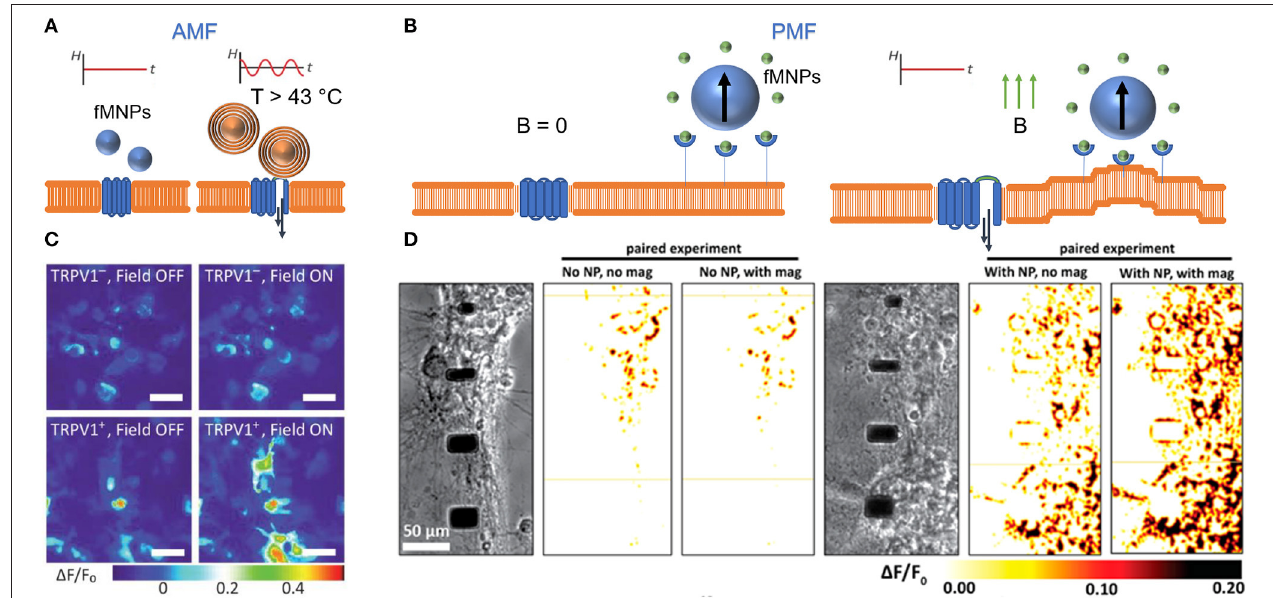
FIGURE 4 | Controlling calcium influx with alternating (AMF) and permanent magnetic fields (PMF). (A) Heat stimulation of TRPV1 through fMNP-mediated heat induction in AMF. (B) FMNP-mediated calcium channel activation via membrane bending in PMF. “B = 0” indicates no magnetic field. (C) False color heat maps show changes in fluorescently-labeled intracellular calcium concentration in TRPV1- and TRPV + HEK293FT cells before and during AMF stimulation. Scale bar = 50 µ m. Reproduce with permission from Chen et al. (2015), Copyright © 2015, American Association for the Advancement of Science. (D) False color heat maps show changes in fluorescently-labeled intracellular calcium influx in primary cortical neurons (E18, rat) with and without fMNPs and with and without PMF stimulation. Reproduce with permission from Tay et al. (2016a), Copyright © 2016, American Chemical Society.